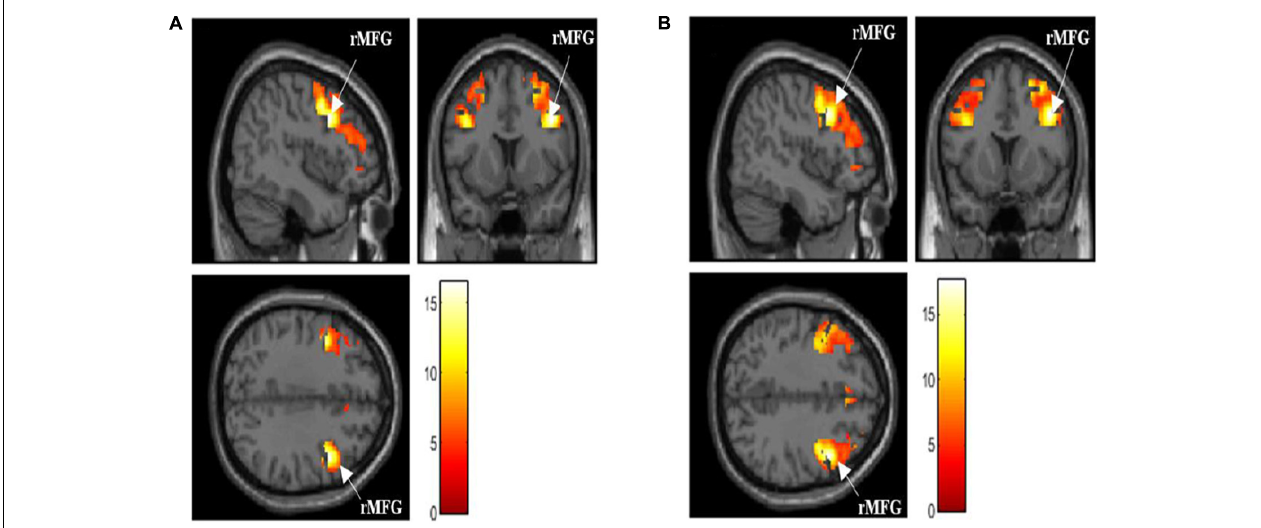
FIGURE 2 | (A) Activated brain region in dorsolateral prefrontal cortex (DLPFC) when performing 0-back task [ p < 0.05, family-wise error (FWE) corrected]. (B) Activated brain region in DLPFC when performing 1-back task [ p < 0.05, FWE corrected]. rMFG, right middle frontal gyrus; activation intensity: Red to White (low to